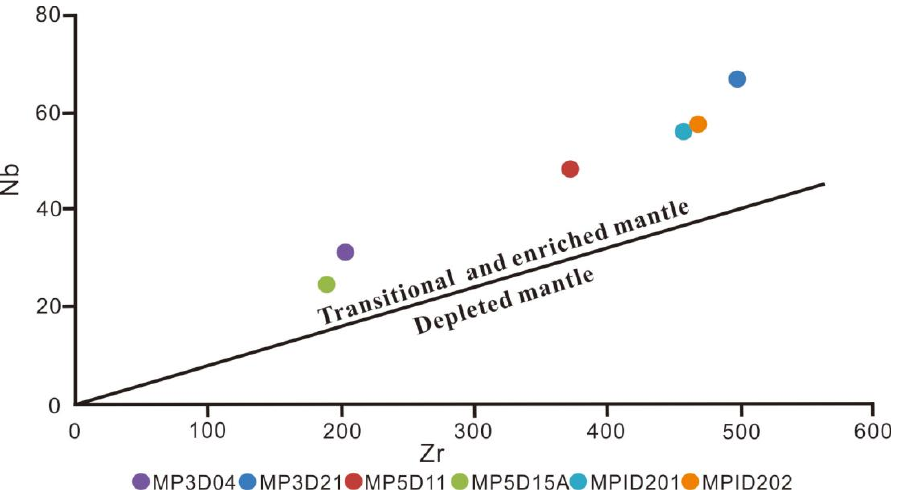
Figure 8. Zr–Nb diagram of seamounts in the Western Pacific (after Barbero, E. et al., 2021 [45]).